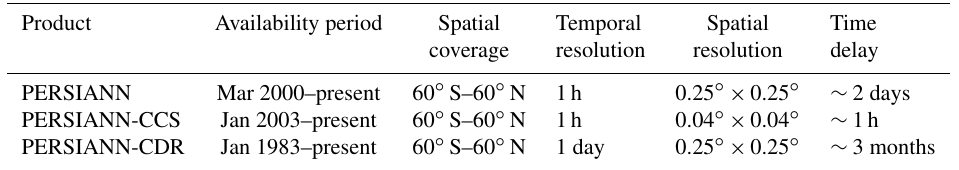
Table 1. Basic attributes of the PERSIANN, PERSIANN-CCS, and PERSIANN-CDR products.